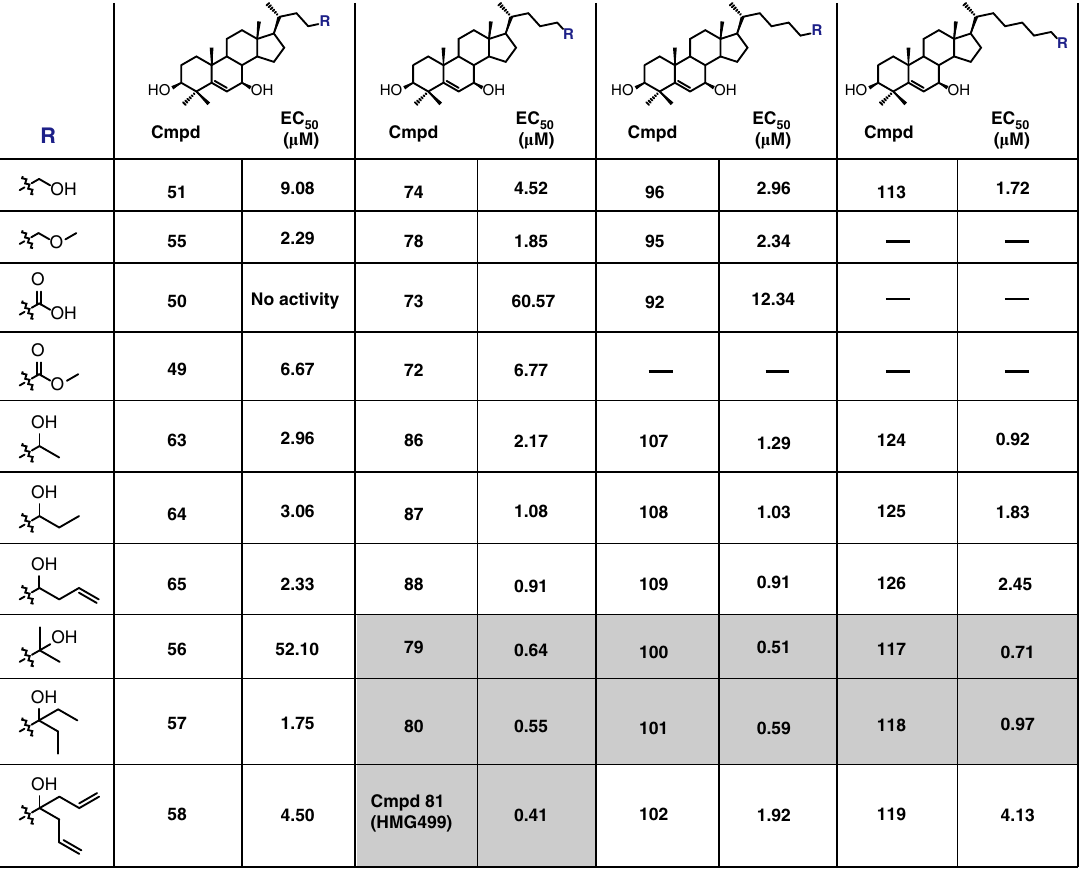
Fig. 4 Summary of the EC 50 values of various compounds. Compounds bearing the 3 β -hydroxyl group, 4,4-dimethyl groups and 7 β -hydroxyl group on the steroid ring but differing in the side chain length or terminal moieties (R) were synthesized. CHG cells were incubated with indicated compounds for 16 h and the mean intensity of GFP from three independent experiments were measured. The EC 50 values were determined with dose – response curves by Prism software. Those with EC 50 values less than 0.75 μ M are highlighted in shadow. Source data are provided as a Source Data File. Dose – response curves of indicated compounds are shown in Supplementary Fig.